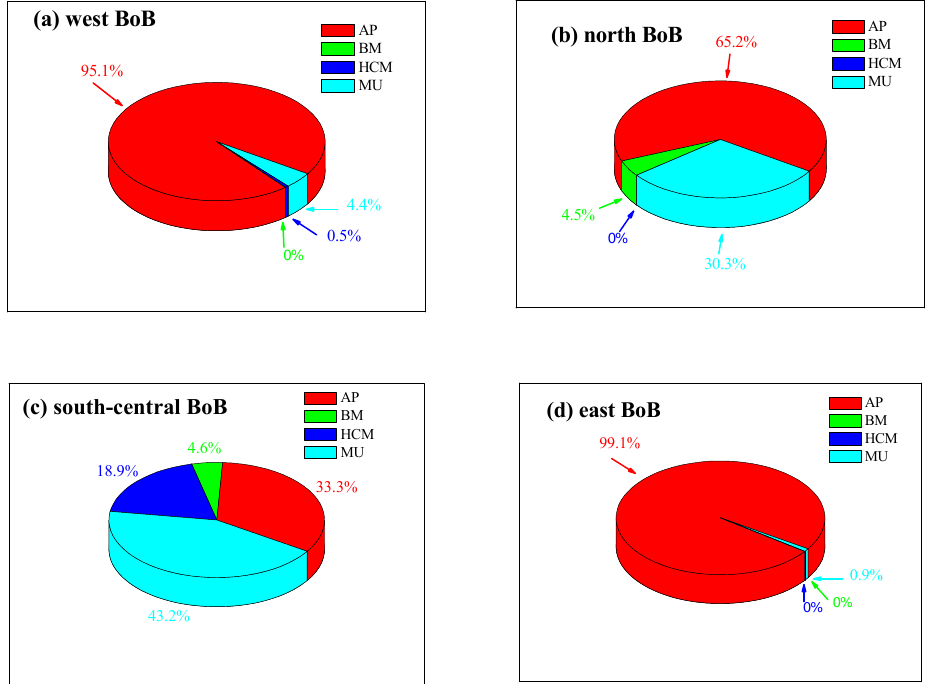
Fig. 6. Fraction pies of each aerosol type over the four BoB sub-regions during W-ICARB: AP (Anthropogenic Pollution, biomass burning included), BM (Background Maritime), HCM (Coarse-Mode for High turbid conditions), MU (Mixed-Undetermined).